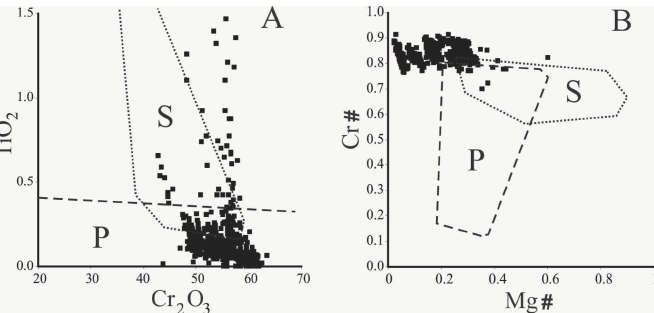
Figure 5. Binary diagrams showing podiform (P) and stratiform (S) chromite fields where >500 chromite analyses from Cedrolina were plotted (modified after [33,34]). ( A ) TiO 2 vs. Cr 2 O 3 ; ( B ) Cr# vs.